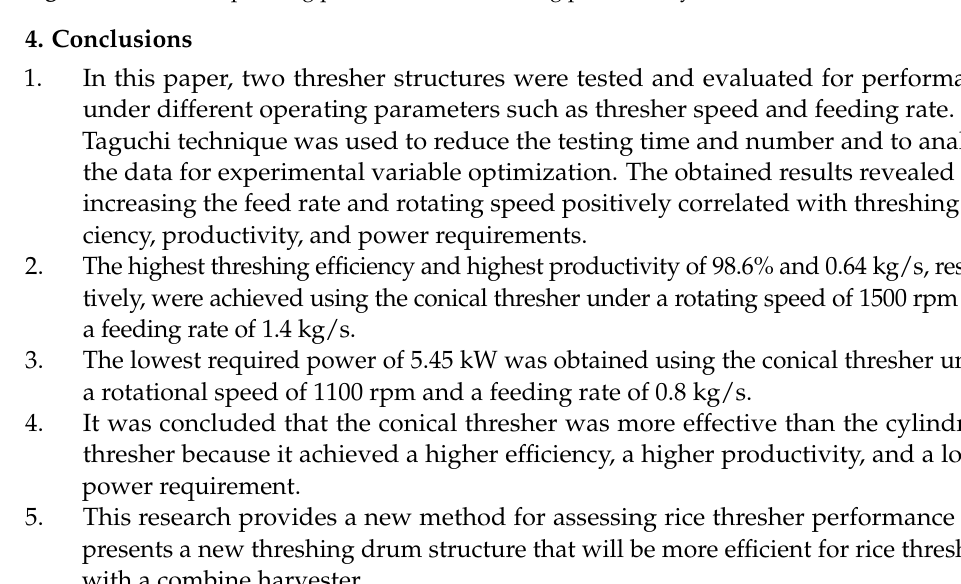
Figure 10. Effect of operating parameters on threshing productivity.